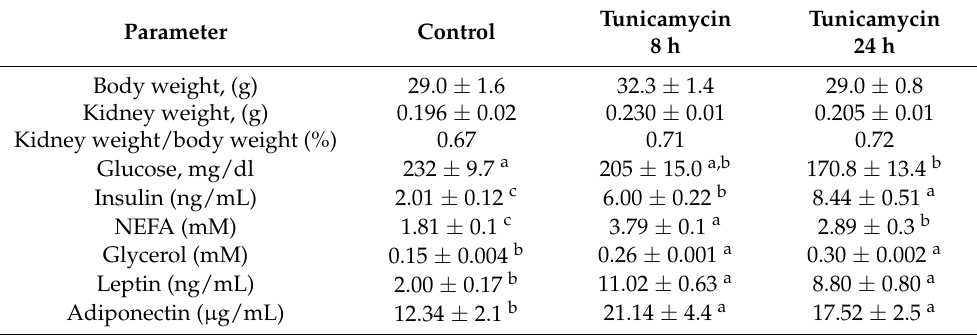
Figure 3. ER stress-induced apoptosis in mouse kidneys. Mice were treated with a single i.p. injection of vehicle or tunicamycin (1 g/Kg body weight), and the kidney was obtained after 8 h (T8) or 24 h (T24). Kidney sections from tunicamycin-treated groups were TUNEL-stained to identify apoptotic cells. Apoptotic cells were not identified in the control group, while apoptotic cells were observed after 8 h and 24 h of tunicamycin treatment ( A ). Assessment of the average percentage of TUNEL-positive cells ( B ). Values are means ± SEM, n = 4–6. Means without a common letter differ significantly, a > b > c ( p < 0.05). Table 1. Body weight, kidney weight and biochemical parameters in mice treated with tunicamycin for 8 h and 24 h.